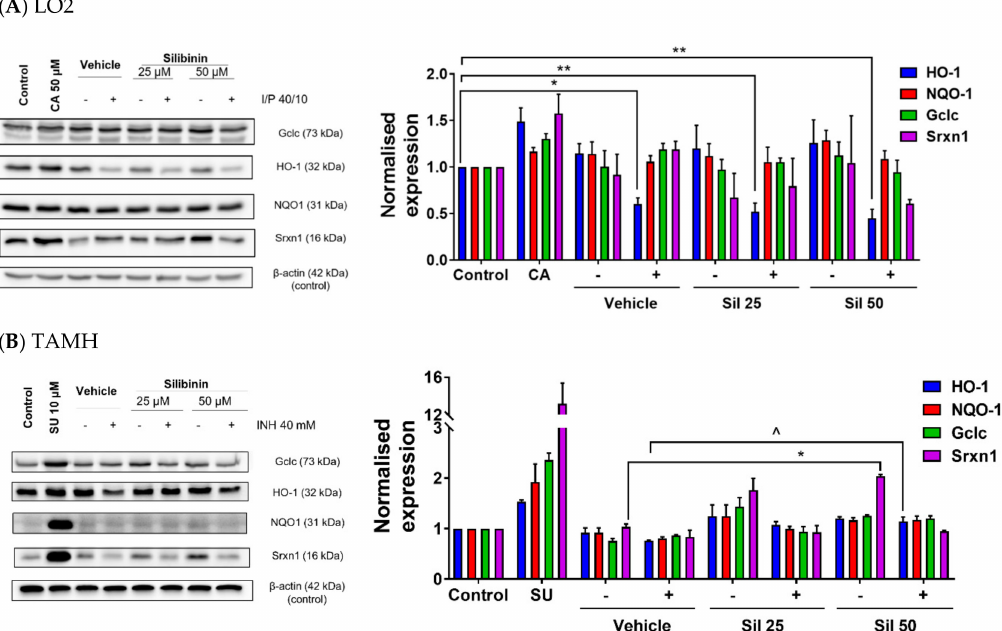
Figure 5. Silibinin induced expression of proteins in the nuclear factor (erythroid-derived 2)-like 2 (Nrf2)–antioxidant response element (ARE) pathway and restored protein expression. Vehicle control was treated with 0.05% v / v dimethyl sulfoxide (DMSO). ‘ − ’ denotes conditions without toxicant cotreatment; ‘ + ’ denotes conditions with toxicant cotreatment. ( A ) In LO2, silibinin’s reduction of ROS levels when co-administered with I / P 40 / 10 was independent of heme oxygenase-1 (HO-1) protein restoration. The administration of I / P 40 / 10 significantly reduced HO-1 levels without silibinin (one-way ANOVA, p = 0.0150), or with silibinin at 25 µ M (one-way ANOVA, p = 0.0051) and 50 µ M (one-way ANOVA, p = 0.0022). Positive controls were treated with the Nrf2–ARE inducer trans-cinnamaldehyde (CA) 50 µ M for 24 h. Data represent mean ± S.E.M. of three replicates. * p < 0.05, ** p < 0.01 vs. negative control. ( B ) In transforming growth factor- α transgenic mouse hepatocytes (TAMH), 50 µ